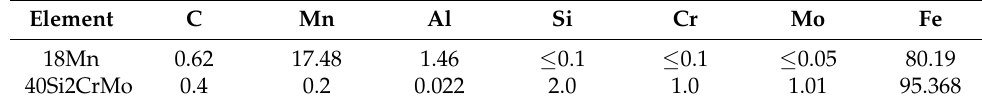
Table 1. The chemical composition of raw 18Mn and 40Si2CrMo [wt.%].